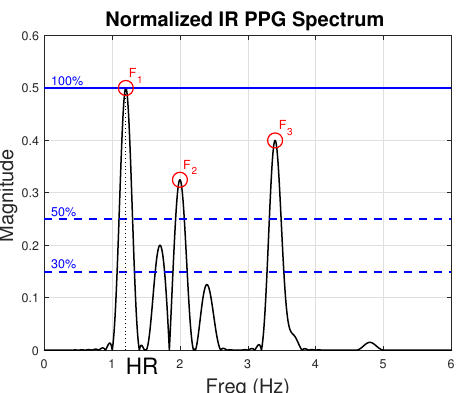
Figure 5. Illustration of the frequency spectrum of a typical IR PPG signal. The red circles correspond to the dominant peaks, denoted F 1 , F 2 , and F 3 (extracted in step 1 of Section 2.3.3). The highest peak, F 1 , corresponds to the participant’s